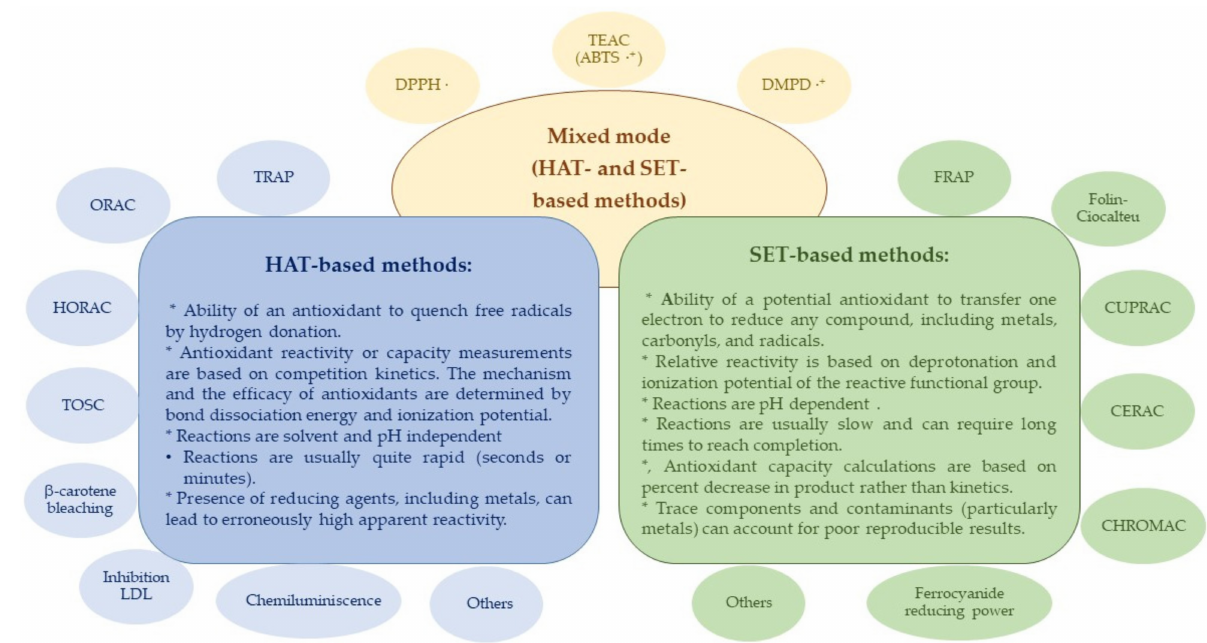
Figure 2. Characteristics of reaction mechanisms and main assays for the determination of antioxidant